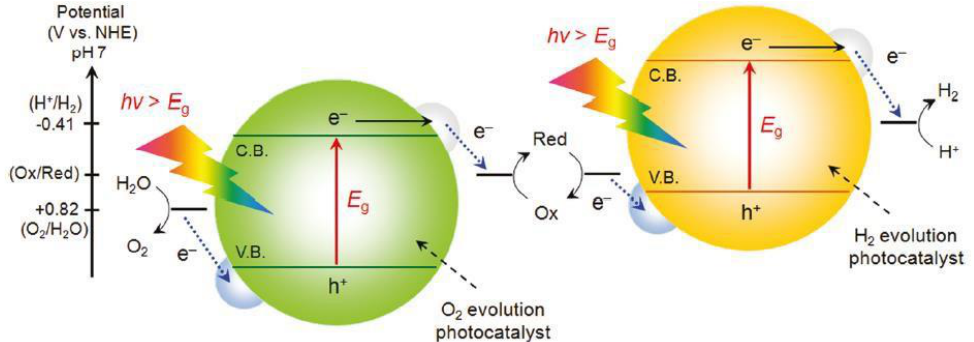
Figure 3. Two-step photoexcitation system with two photocatalysts in tandem (PEC water splitting). Reprinted with permission from [16]. Copyright 2022 American Chemical Society.